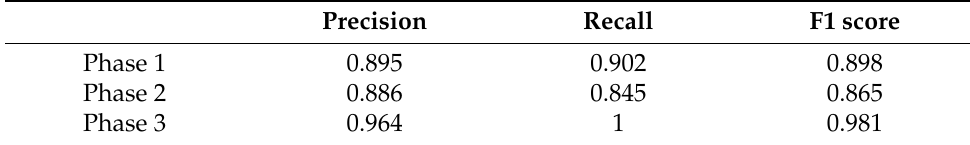
Table 4. Performance evaluation of the classifier based on the Precision, Recall and F1 score